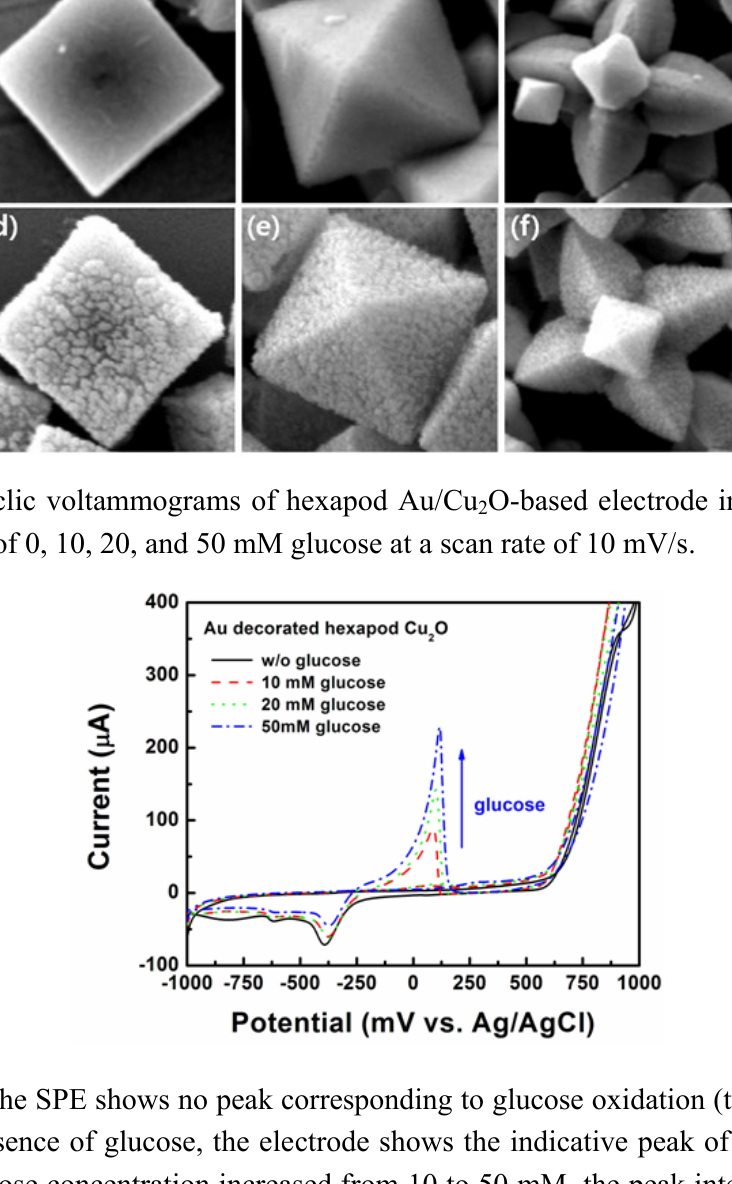
O; ( c ) hexapod Cu 2 O. 2